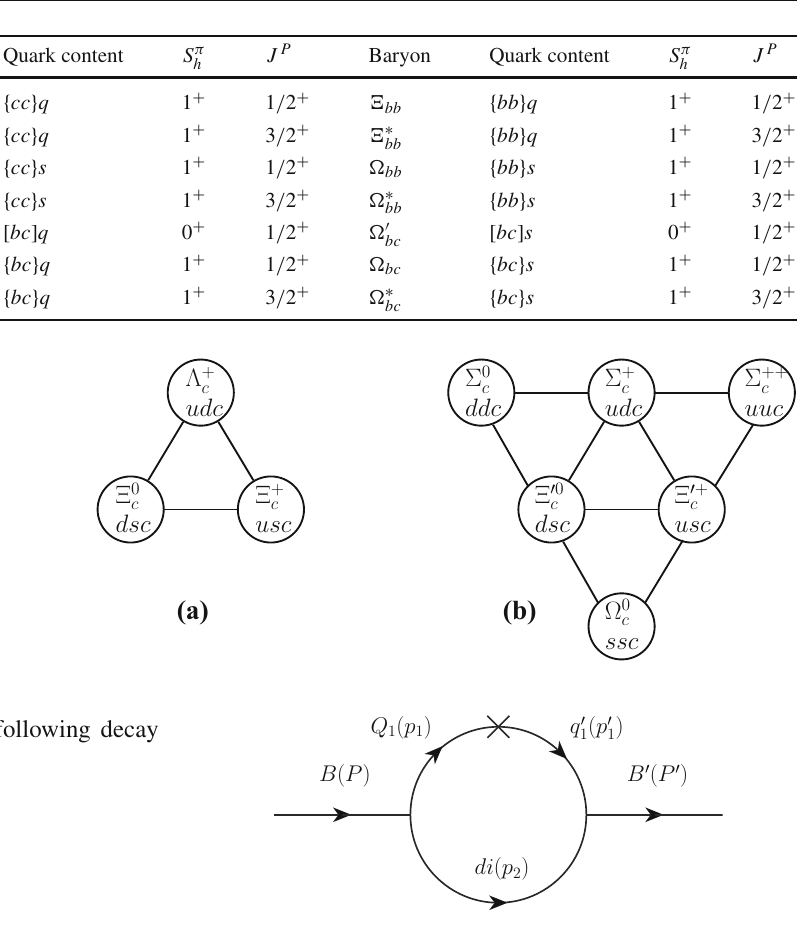
Fig. 2 Feynmandiagramsforbaryon–baryontransitionsinthediquark picture. P ( (cid:3) ) is the momentum of the incoming (outgoing) baryon, p is the initial (final) quark momentum, p 2 is the diquark momentum and the cross mark denotes the weak